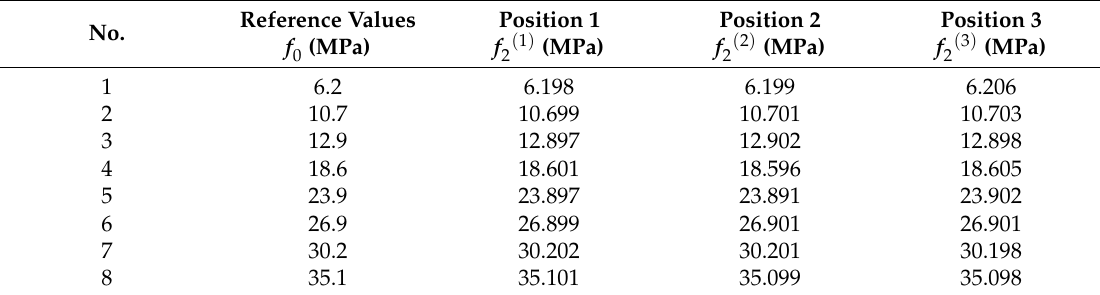
Table 5. Comparison of the results of readings measured by proposed methods in the meter image taken from three